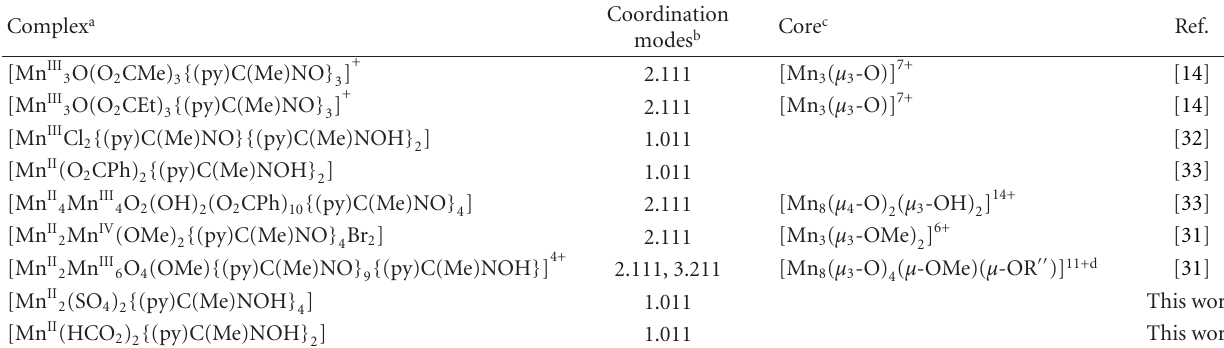
Table 6: Formulae, coordination modes of the ligands, and cores of the structurally characterized Mn complexes of (py)C(Me)NOH